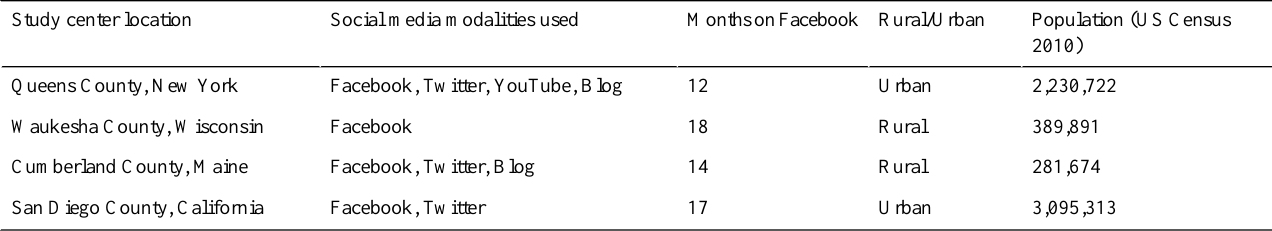
Table 1. Study center characteristics and social media use by